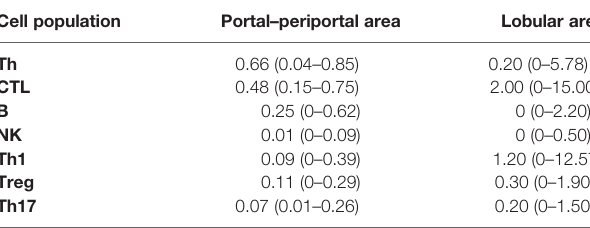
TABLE 2 | Quanti fi cation of liver cell